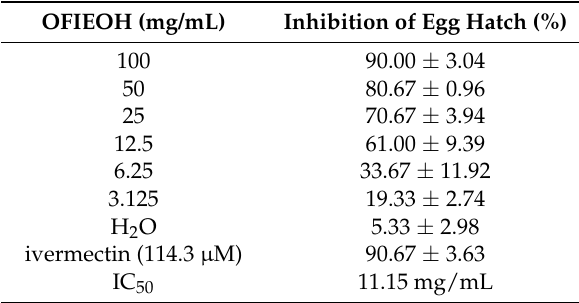
Figure 2. Effect (percentage and standard deviation) on ( a ) egg hatch and ( b ) larval migration of Opuntia ficus-indica essential oil (OFIEOH) against gastrointestinal nematodes of sheep. Table 2. Percentage (±standard deviation) of inhibition of egg hatch of gastrointestinal nematodes in the presence of Opuntia ficus-indica essential oil (OFIEOH) from cladode peels. The IC 50 was based on the extract calculations and ivermectin was used as positive control.